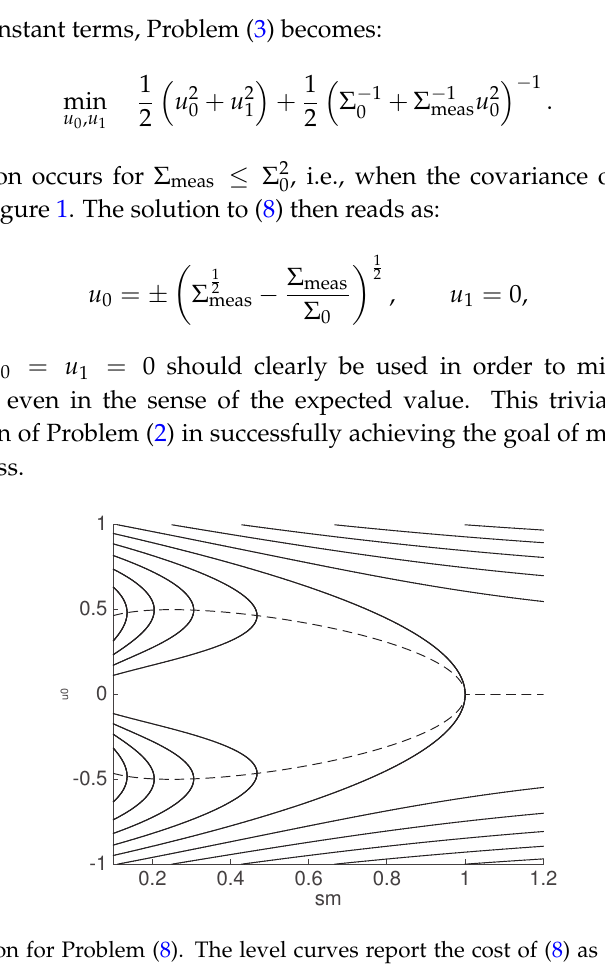
0 for various values of